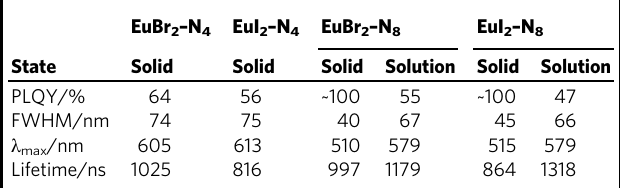
Table 2 The summary of photoluminescent properties of the four Eu X 2 – N n